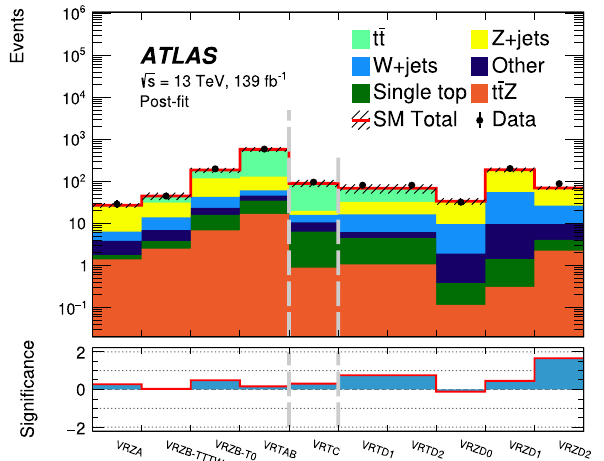
Fig. 11 Event yields comparing data (points) to the SM prediction (stacked histograms) in all signal regions after the SRA–B, SRC and SRDbackground-onlyfits.ThehatcheduncertaintybandaroundtheSM predictionshowsthetotaluncertainty,whichincludestheMCstatistical uncertainties, detector-related systematic uncertainties, and theoretical uncertainties. The signal regions included in the SRA–B, SRC and SRD fits are separated by vertical dashed